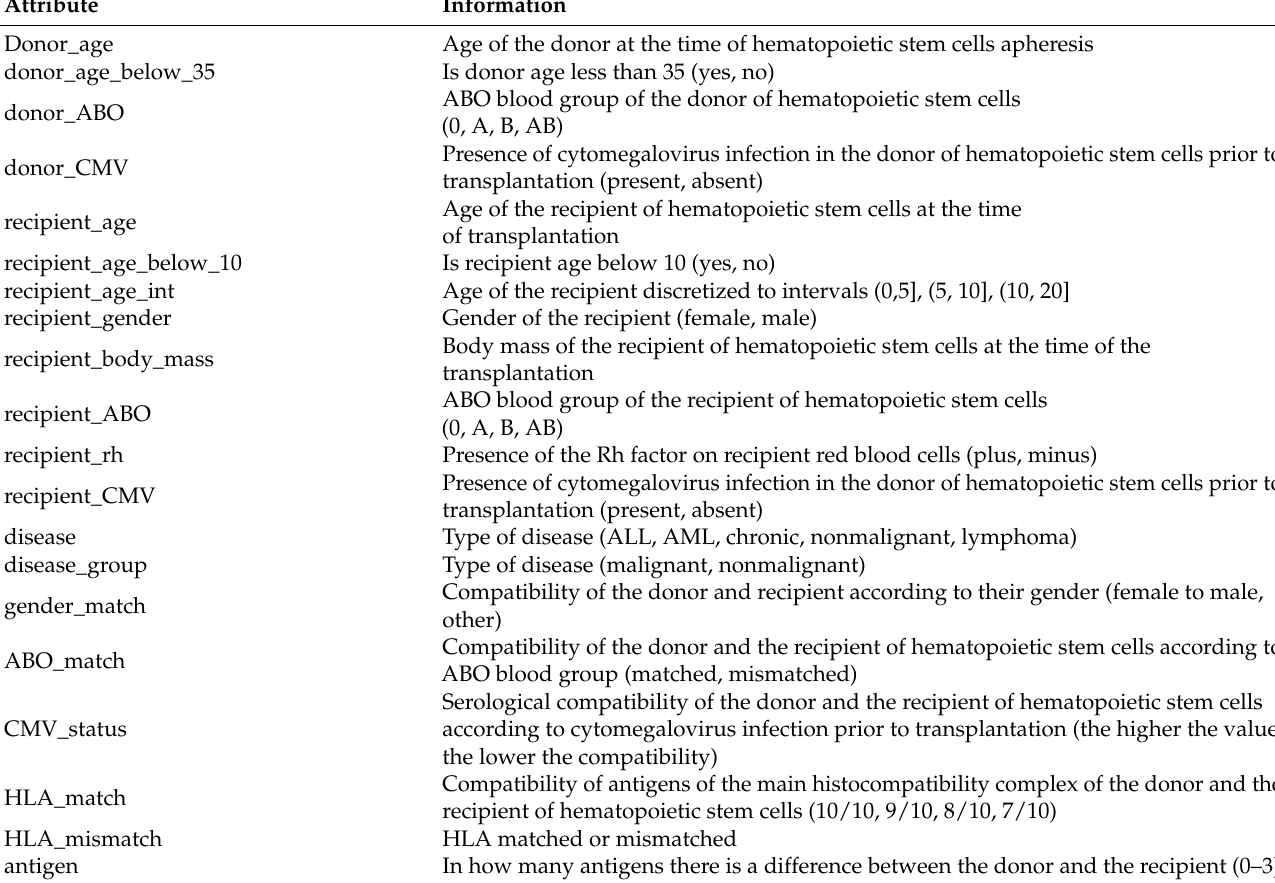
Table A1. Dataset